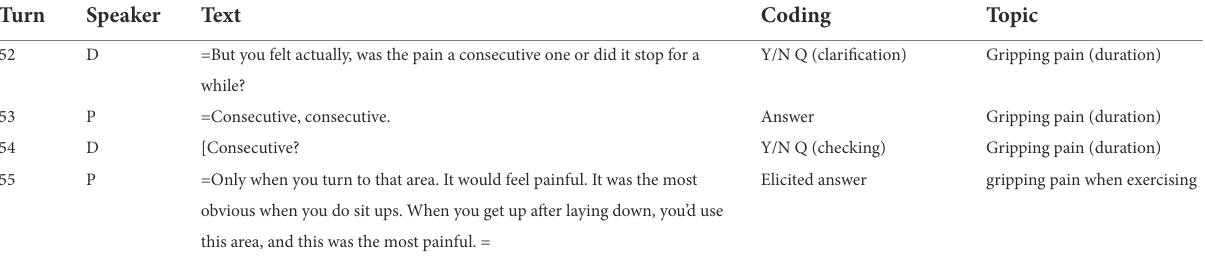
TABLE 1 Example of managing uncertainty during collaborative decision-making to achieve